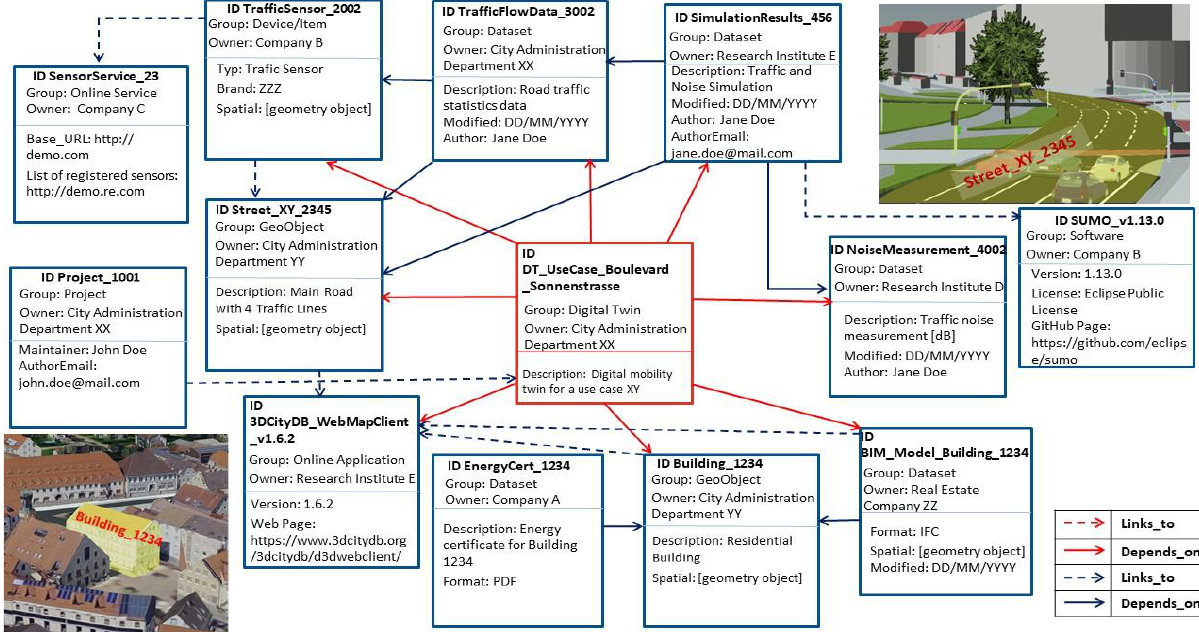
Figure 3: Example for a Distributed Digital Twin represented by connected catalog entries of different types and owned by different stakeholders. Note, that each catalog entry has many further metadata